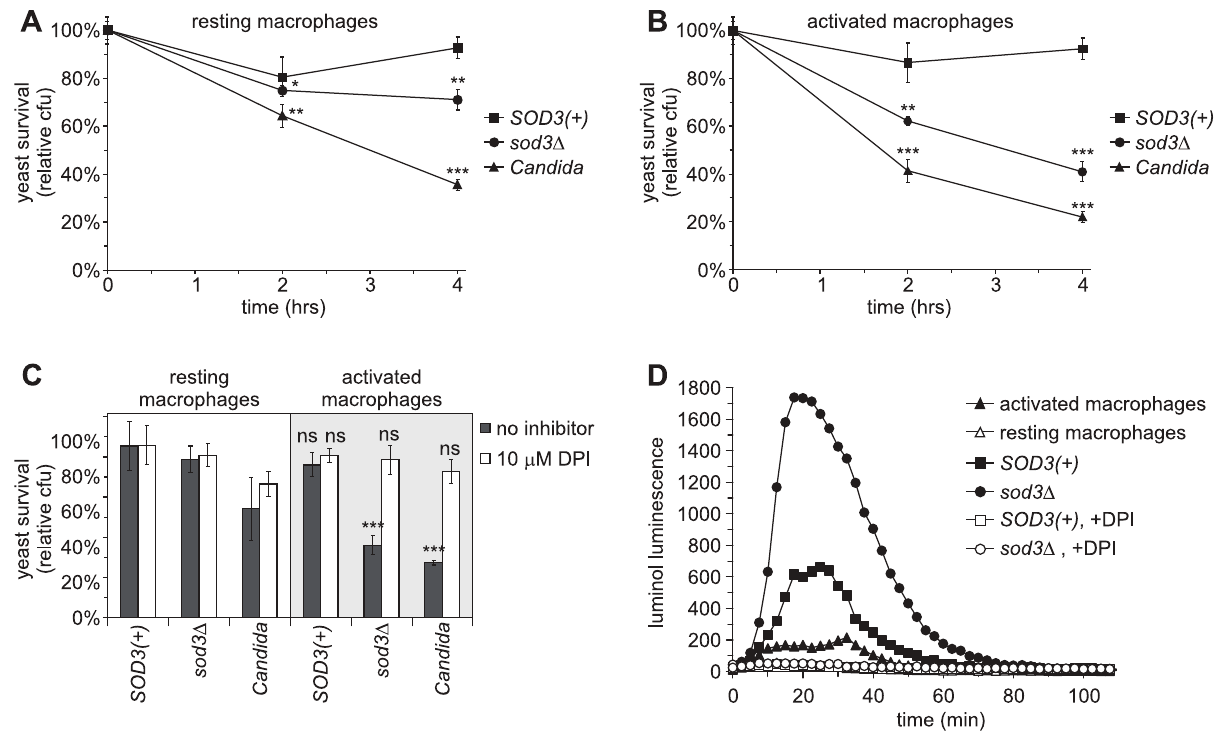
Figure 6. Sod3 protects Histoplasma yeasts from ROS produced by activated macrophages. ( A–B ) Survival of yeasts after infection of resting ( A ) or cytokine-activated ( B ) murine macrophages. SOD3( + ) (OSU45), sod3 D (OSU15) and Candida albicans yeasts were added to resident peritoneal macrophages at an MOI of 1:50. Yeast survival was determined by enumeration of viable cfu after 2 and 4 hours of co-incubation of yeasts with macrophages at 37 u C. In ( B ), 10 U TNF a and 100 U IFN c were added to macrophages 24 hours prior to infection to enhance ROS production. Results are plotted as relative yeast survival (mean 6 standard deviation of 3 replicates) compared to viable cfu of yeasts incubated in the absence of macrophages. Significantly decreased survival compared to SOD3( + ) yeasts is indicated by asterisks (* p , 0.05, ** p , 0.01, *** p , 0.001). ( C ) Prevention of yeast killing by macrophages after inhibition of the NADPH-oxidase. Yeasts were added to resting and to IFN c /TNF a -activated macrophages and incubated for 4 hours at 37 u C in the absence or presence of 10 m M diphenylene iodinium (DPI) and viable cfu were determined. Results indicate relative yeast survival (mean 6 standard deviation of 3 replicates) compared to viable cfu of yeasts incubated in the absence of macrophages. Significant (** p , 0.01) or non-significant (ns) reduction in survival compared to yeasts in the absence of macrophages is indicated above the respective columns. ( D ) Reactive oxygen production by activated macrophages in response to Histoplasma yeasts. Histoplasma yeasts were added to resting or activated macrophages at an MOI of 1:1 in the presence of the luminol ROS-detection reagent and the luminol luminescence measured over time. Macrophages and yeasts were co-incubated in the presence (open symbols) or absence (closed symbols) of 10 m M DPI to inhibit the NADPH-oxidase. Data points represent the mean luminescence